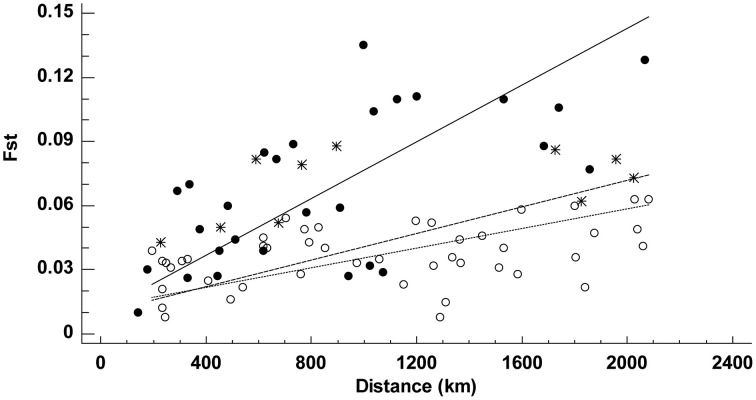
Relationship between geographic and genetic (FST) distances among 19 populations of Arbutus unedo. Separated analyses were conducted for Atlantic (solid circles) and Mediterranean (asterisks and open circles) populations; asterisks denote pairwise comparisons with population FM. Lines are reduced major axis regressions for the Atlantic group (solid line, r = 0.64, P = 0.990), the Mediterranean group (dashed line, r = 0.36, P = 0.991), and the Mediterranean group with FM excluded (dotted line, r = 0.43, P = 1.000).